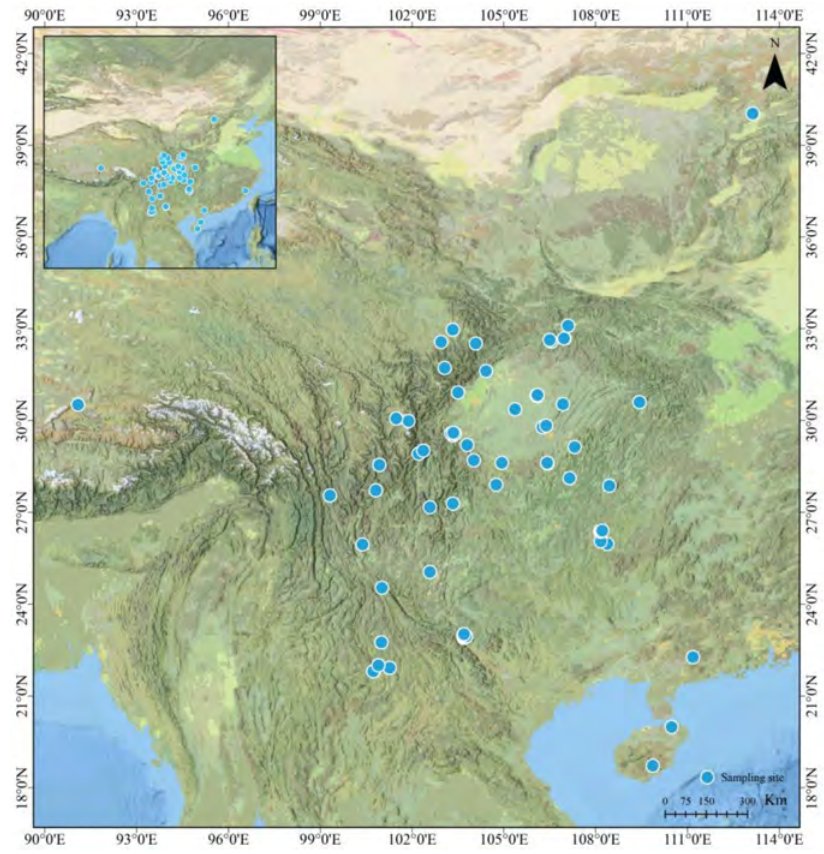
Figure 1. Distribution map of sampling